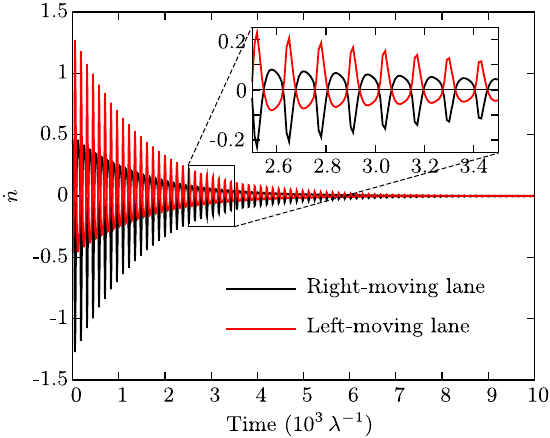
FIG. 7. Particle exchange across the cluster-lane boundaries in the long-time limit. In the plots, t ¼ 0 corresponds to a simulation 10 000 λ − 1 , during which the cluster-lane pattern time of t sim ¼ 0 . Particle has developed from random initial conditions at t sim ¼ exchanges across the cluster-lane boundaries are driven by cluster grazing (spikes) and lateral diffusion of clusters (bumps); see the inset. In the long-time limit, the magnitude of the instantaneous value of the net particle exchange _ n across the cluster-lane boundaries converges to